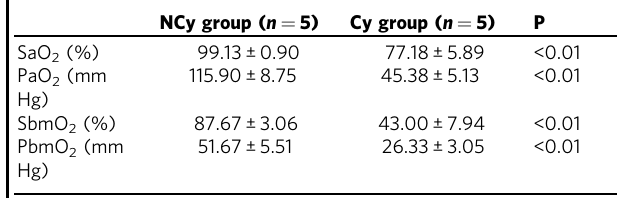
Table 2 Arterial and BM blood gas analysis in the NCy